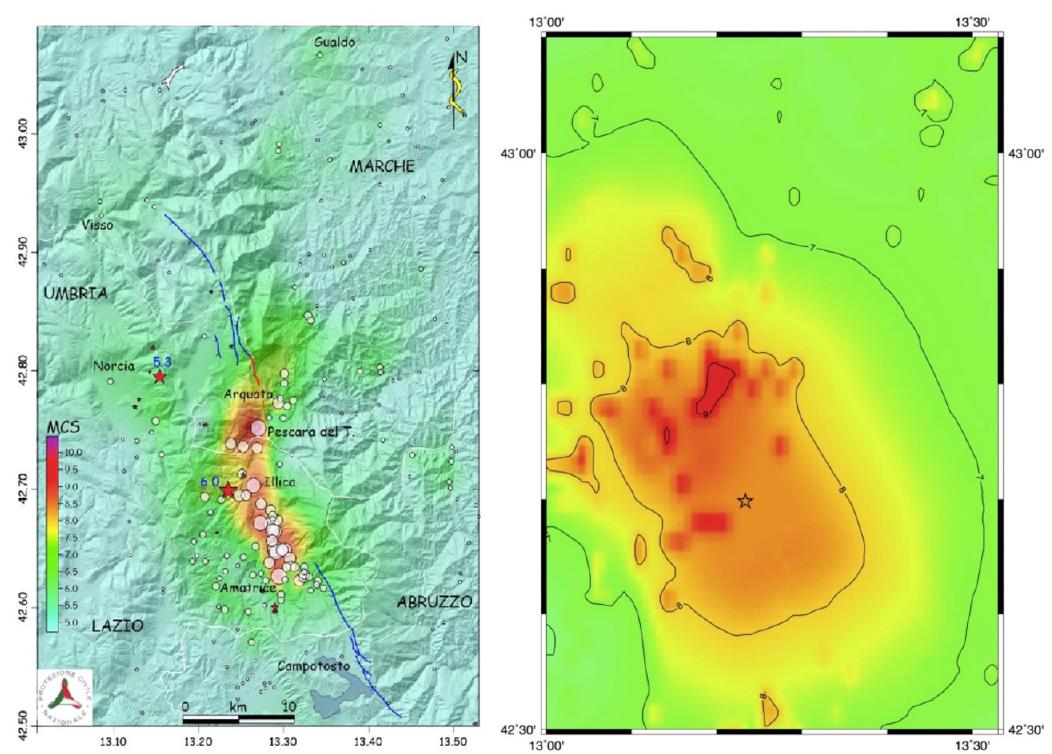
Figure 5. Comparison between the reported macroseismic intensities and the estimated intensities obtained using Shakemap represented using the same color palette.. Left: preliminary macroseismic map compiled by the field macro- seismic teams (from “Rapporto sugli effetti macrosismici del terremoto del 24 Agosto 2016 di Amatrice in scala MCS” a cura di P. Galli e E. Peronace, Coordinamento del rilievo macrosismico MCS a cura di P. Galli e A. Tertulliani, 2016). Right: MCS intensity values obtained with the final shakemap updated with the manually revised